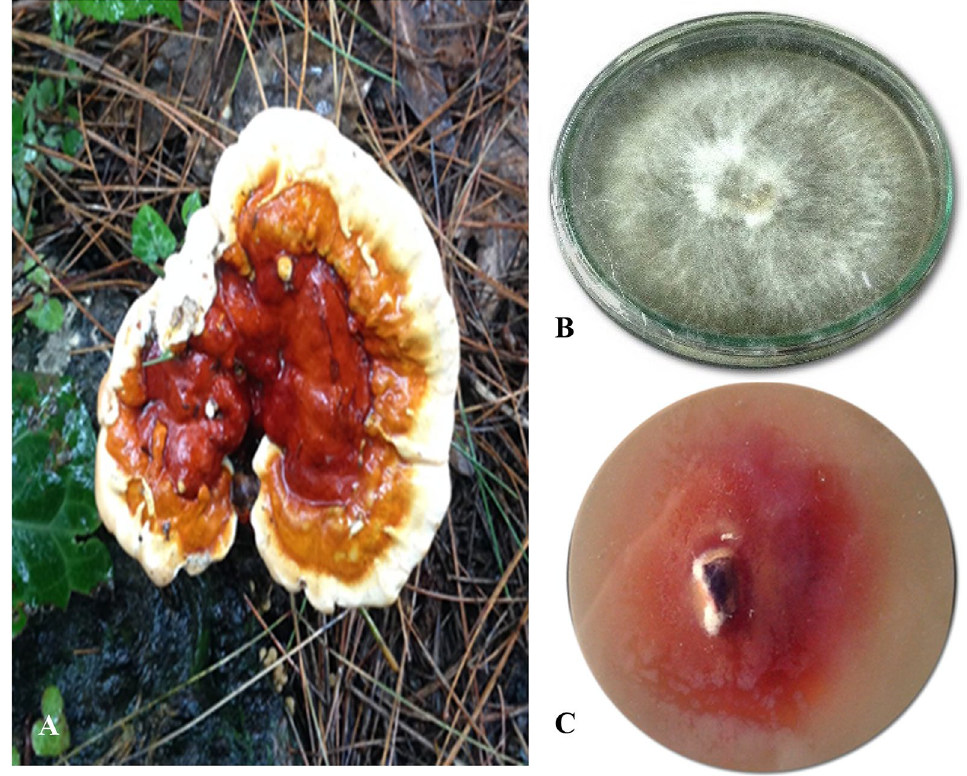
Figure 1. ( A ) Ganoderma leucocontextum Basidiome. ( B ) MEA Plate of Pure Mycelium. ( C ) Guaiacol Oxidase Halo (All photographs were taken by Aisha